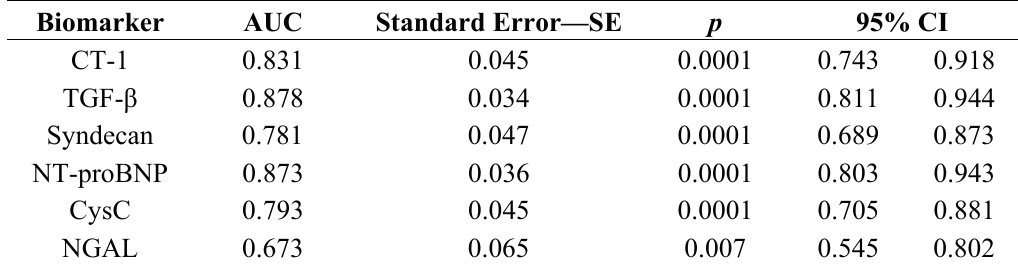
Table 2. Biomarkers with significant discriminative value for heart failure.